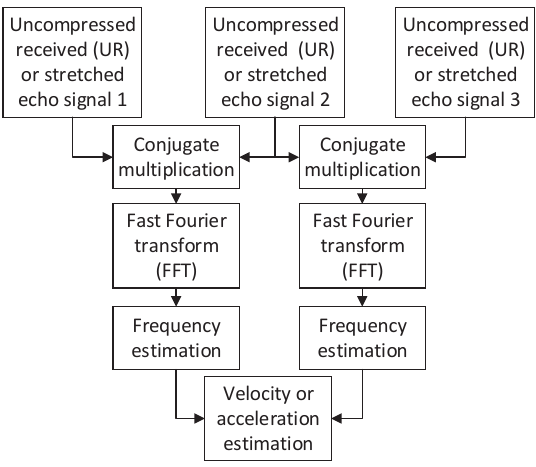
Figure 3. The flowchart of the proposed cross-correlation of adjacent echoes (CCAE)